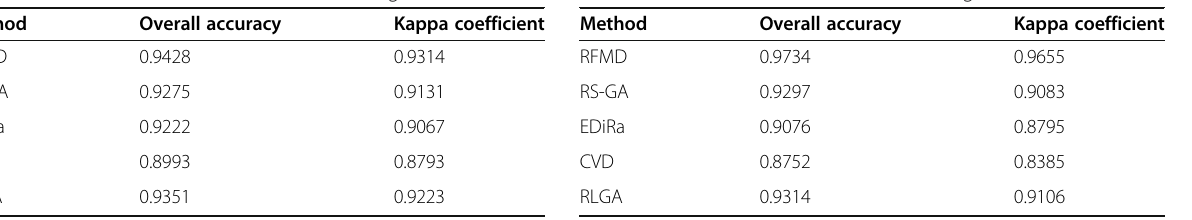
Table 12 Classification results in Landsat 8 image Table 13 Classification results in GF-2